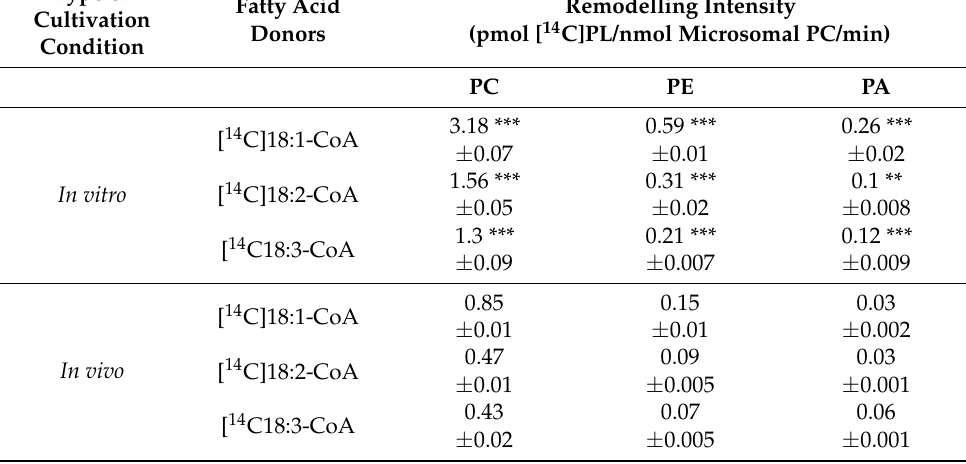
Table 2. Remodelling intensity—[ 14 C]acyl group incorporation from [ 14 C]acyl-CoA into PC, PE and PA of microsomal fractions of Camelina sativa leaves cultivated in in vivo and in vitro growth conditions. Asterisks indicate significant difference between remodelling intensity (in assays with each tested acyl donor) of indicated phospholipids of microsomal fractions from leaves cultivated in vivo and in vitro in a two-tailed Student’s t -test, ** p ≤ 0.01, *** p ≤ 0.001. Type